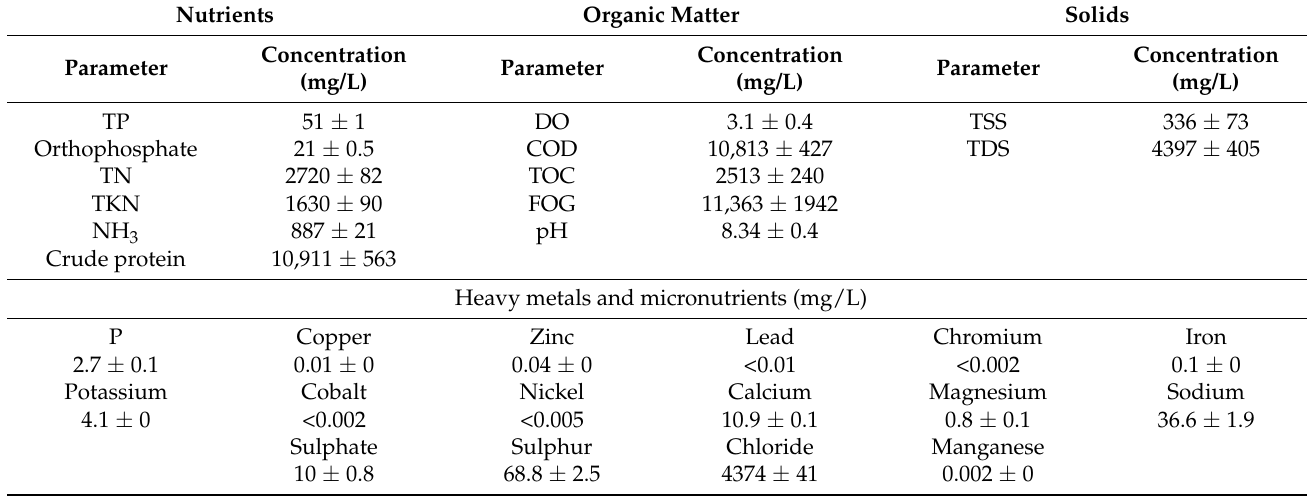
Table 2. Physiochemical characterisation of RCWW ( n = 3).